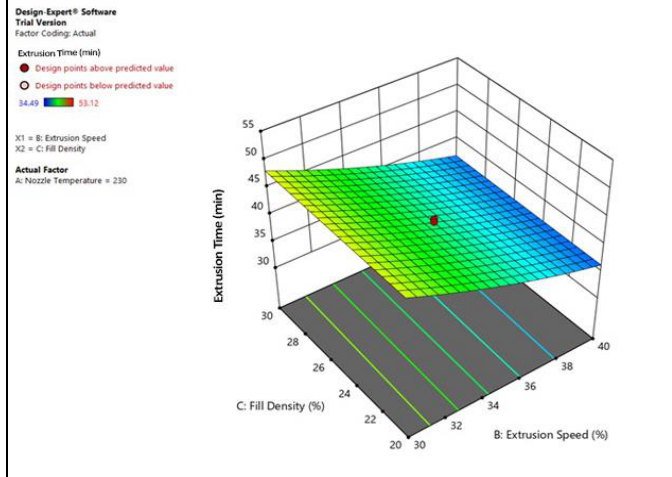
Fig. 11. Interaction effect analysis of factor B and C for the extrusion time.